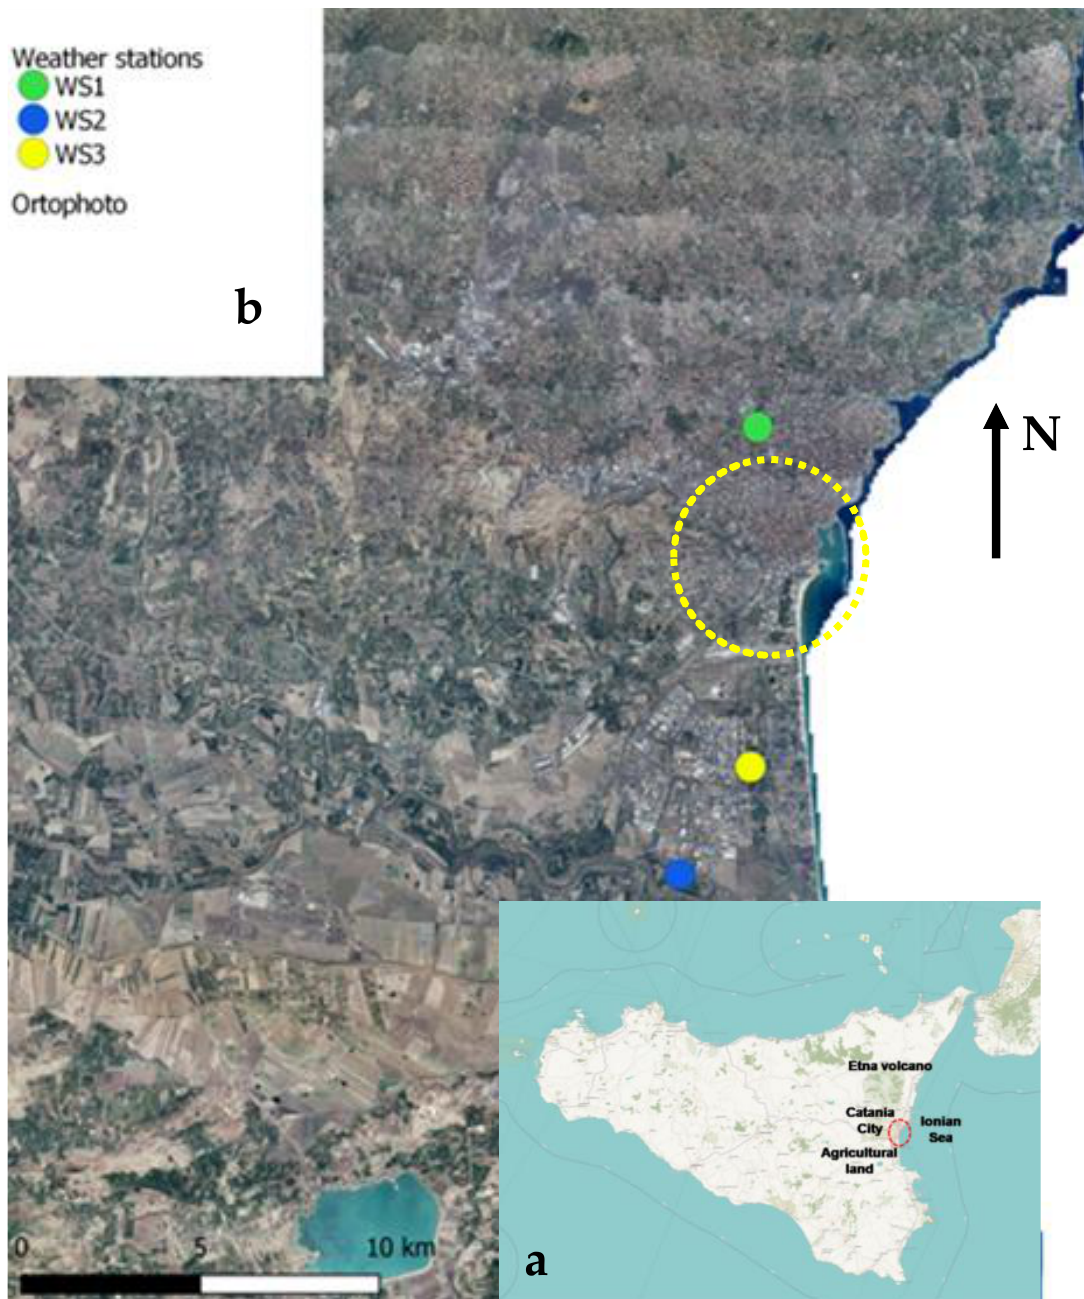
Figure 1. ( a ) Geographic position of Catania city, object of the study; ( b ) localization of the urban centre of Catania (yellow circle) and the three WSs.